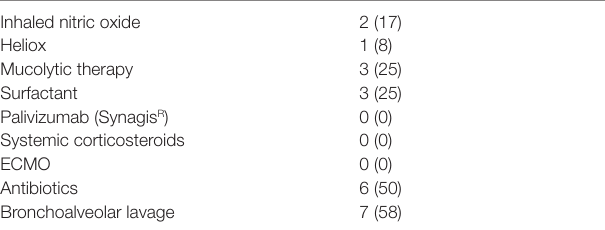
TaBle 2 | Therapies ( n = 12 hFJV courses); data are absolute counts